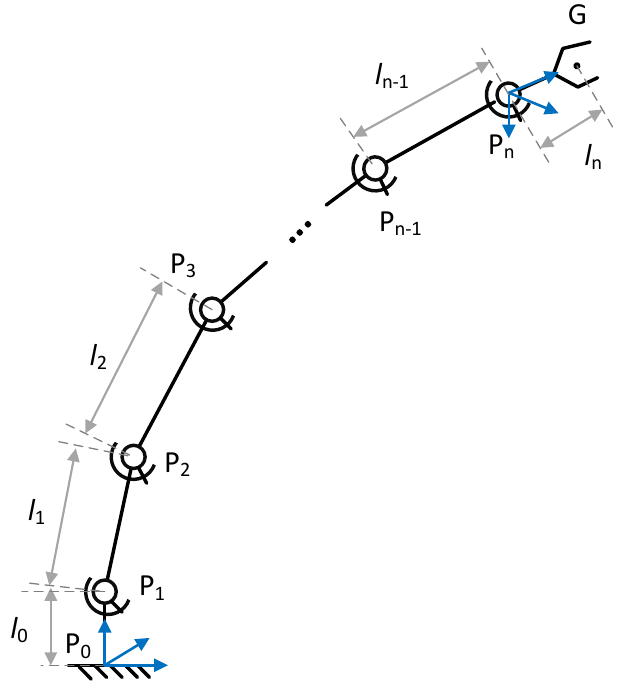
Figure 1. Kinematic diagram — equivalent robot model.